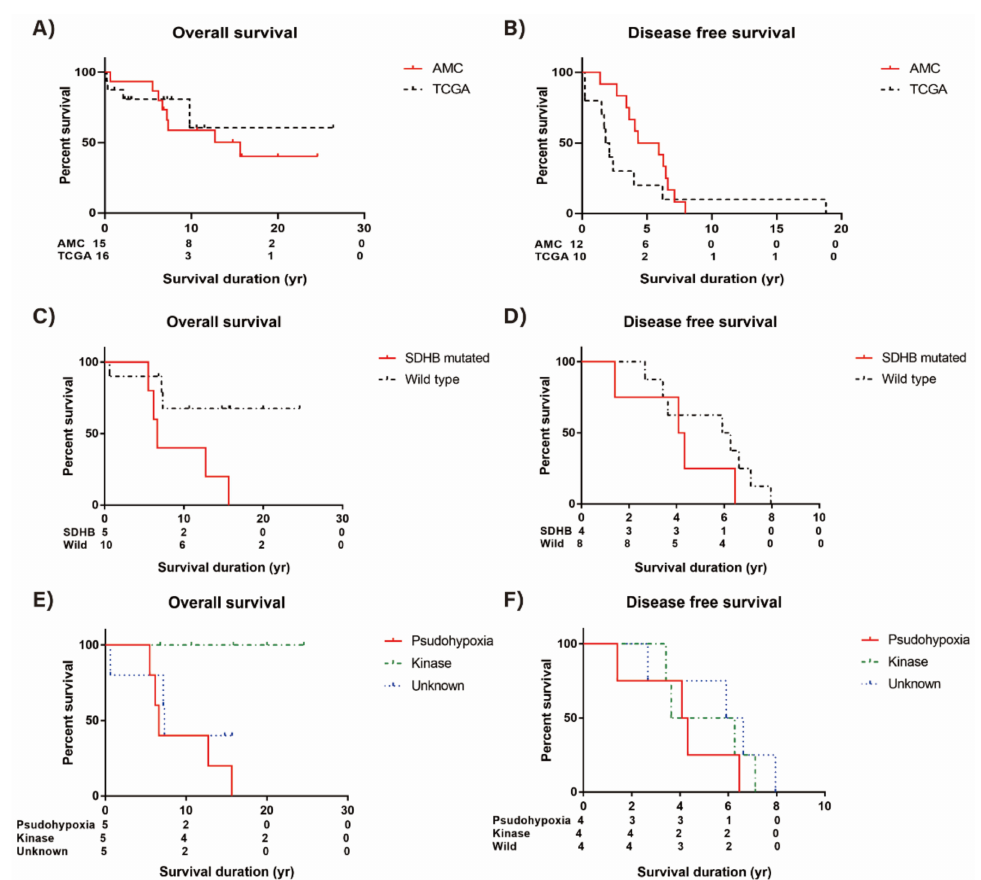
Figure 5. Survival of aggressive pheochromocytoma and paraganglioma (PPGL). ( A ) Overall survival (OS) of AMC and TCGA cohort, ( B ) Disease free survival (DFS) of AMC and TCGA cohort, ( C ) OS difference of AMC subjects according to SDHB mutation, ( D ) DFS difference of AMC subjects according to SDHB mutation, ( E ) OS difference of AMC subjects according to mutation subtypes, and ( F ) DFS difference of AMC subjects according to mutation